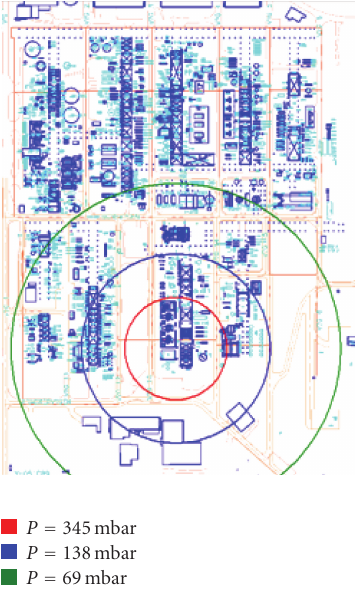
Figure 7: Cloud shape D1538. The cloud covers parts of the third and forth southern process areas.